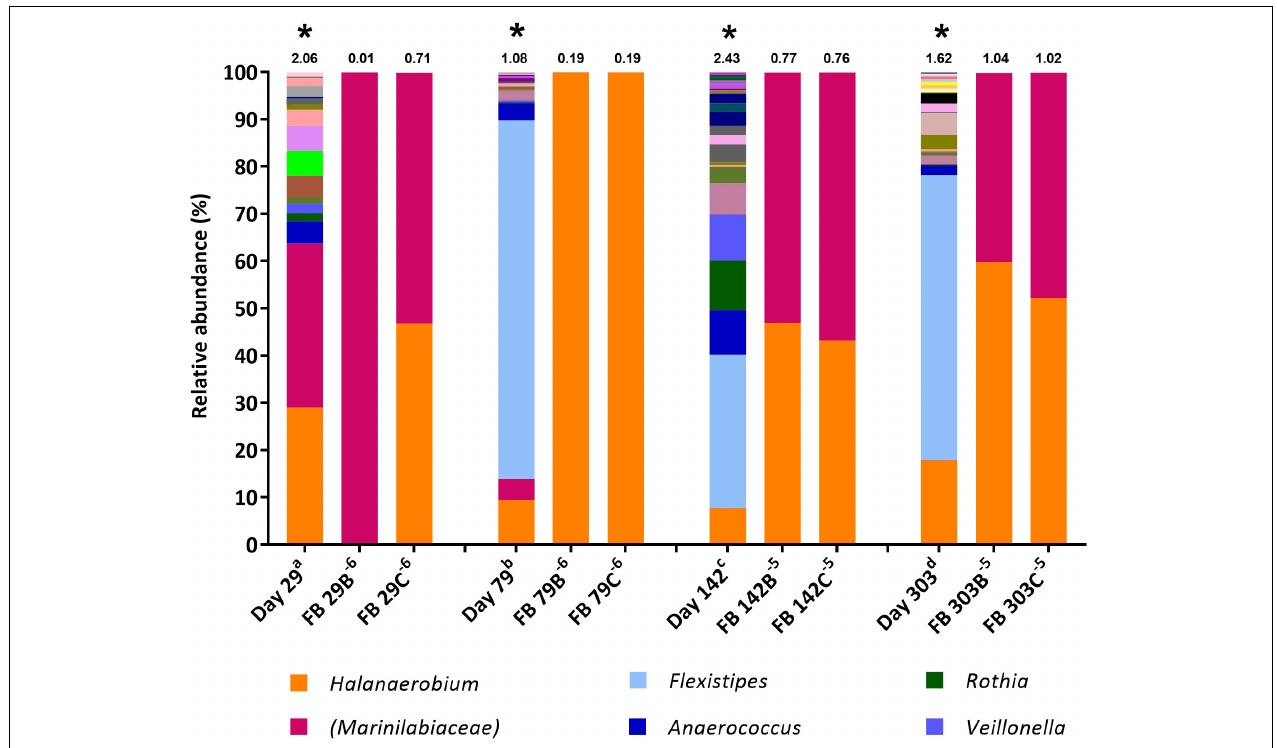
FIGURE 2 | Genus-level microbial community composition of fermentative bacteria (FB) MPN enrichments based on 16S rRNA gene sequencing. Enrichments were conducted at 8% salinity. Where genus level could not be resolved the last matched taxonomic level was assigned in brackets. The Shannon diversity index calculated from operational taxonomic units is displayed above each bar. a 808 days storage, b 758 days storage, c 695 days in storage, and d 534 days storage. * indicates inocula. Key taxa are highlighted in legend. Enrichments were conducted in triplicate where A, B, C refers to specific replica and superscript power refers to dilution factor of the positive end-points